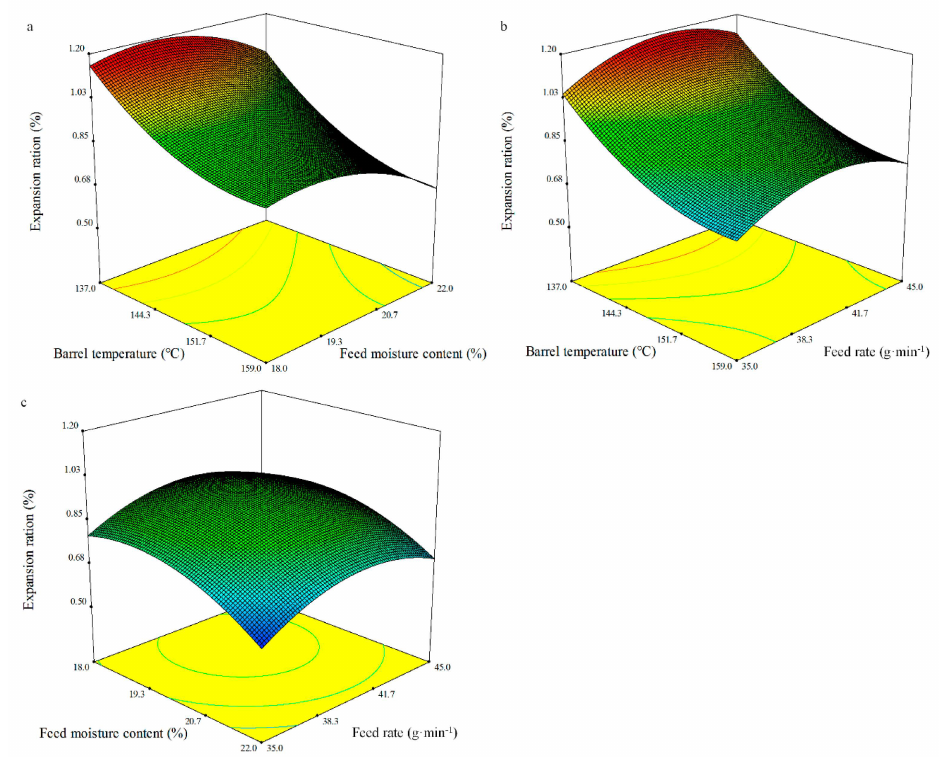
Figure 2. Response surface plot of the expansion ratio of the whole BGW